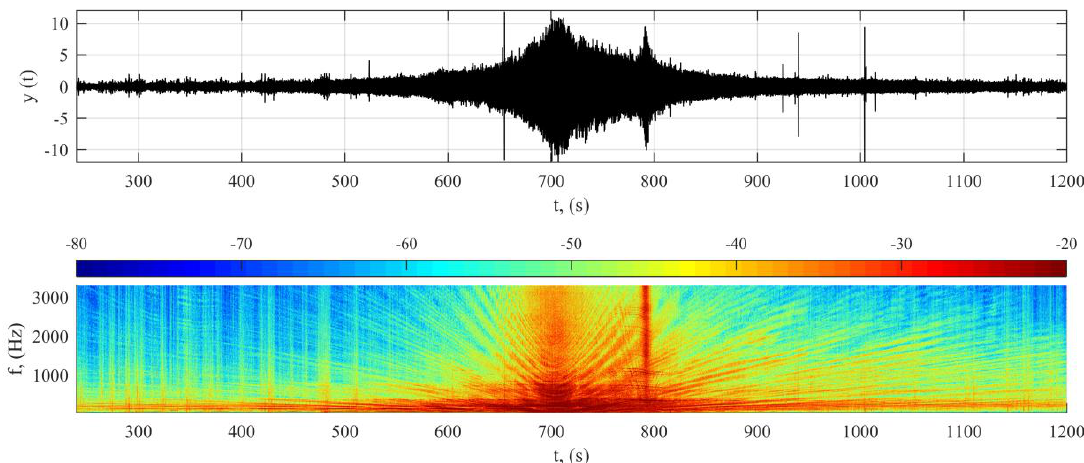
Figure 1. Oscillogram (top) and spectrogram (bottom) of the signal at the hydrophone preamplifier output during the passage of a vessel and a boat. Over the spectrogram there is a scale that illustrates the dependence of color on the levels of spectral components of the signal in dB. The scale is conventional.